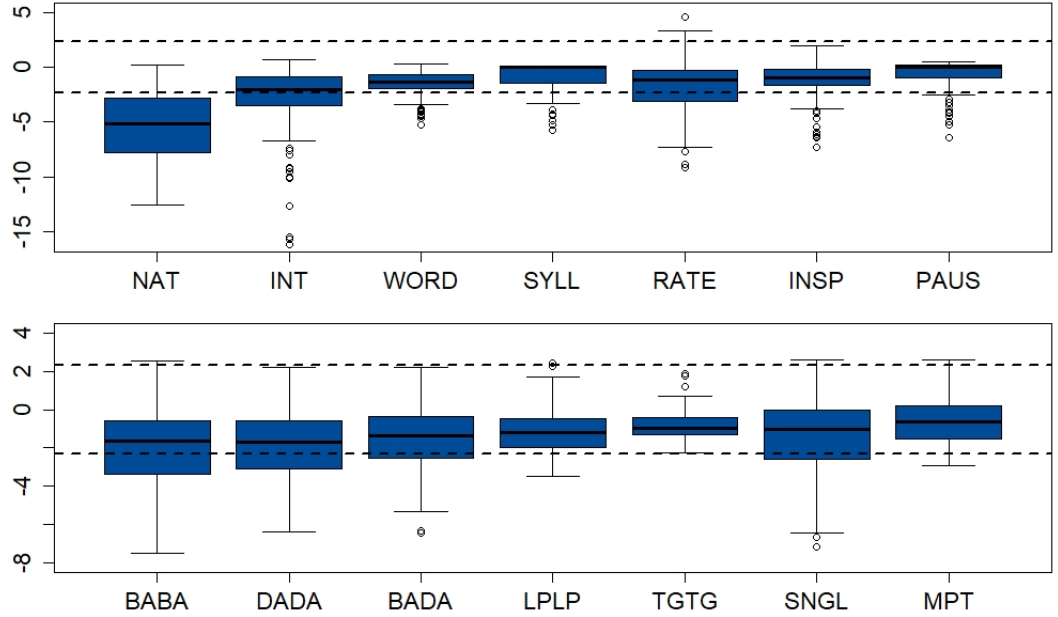
Figure 1. Distributions of standardized speech- ( top panel ) and nonspeech parameters ( bottom panel ) in the patient group ( n = 130). Dashed horizontal lines demarcate the 1% and the 99% cutoffs of the control participants ( n = 130). Note the different scale widths of the y-axes in the two panels. NAT: naturalness; INT: intelligibility; WORD: articulatory accuracy of consonants and vowels in word context; SYLL: articulatory accuracy of consonants in syllable context; RATE: articulation rate (acoustic); INSP: total duration of inspiration pauses; PAUS: total-duration of non-respiratory pauses; BABA, DADA, BADA: DDK syl rate (syllables /ba/, /da/, /bada/); LPLP: repetition rate of